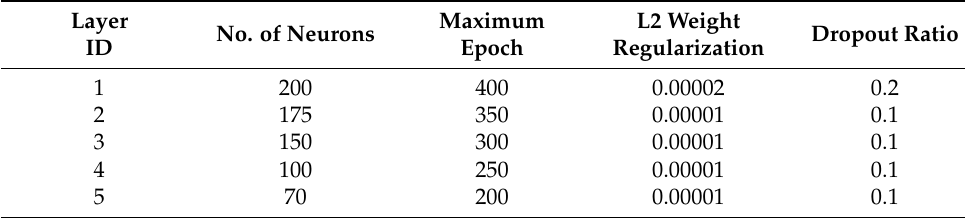
Table 1. The optimal fine-tuned configuration selected for Windfarm 1. Layer